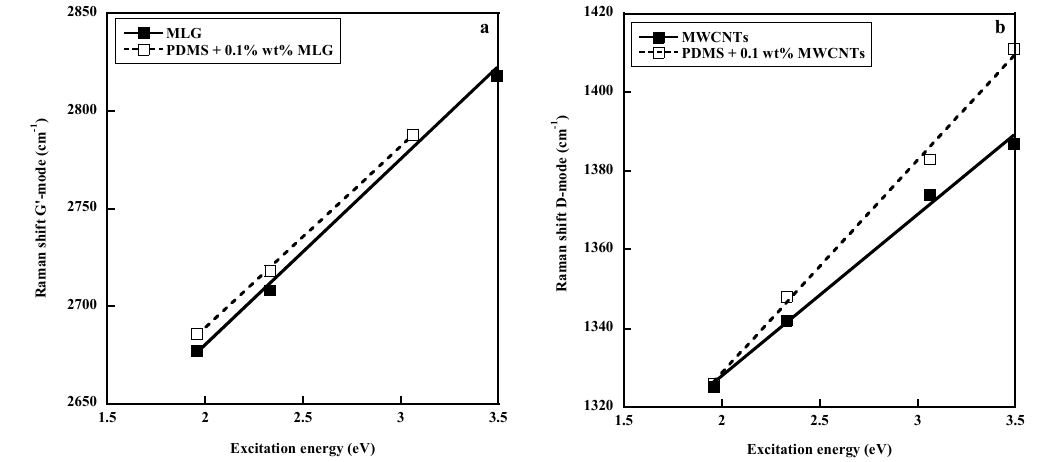
Figure 10. Comparison of the dispersive behavior of multilayer graphene MLG ( a ) and multiwall carbon nanotubes (MWCNTs) ( b ) in the pure state and embedded in a poly(dimethylsiloxane) (PDMS) matrix. Reprinted with permission from Elsevier. Reproduced by permission of Elsevier from L. Bokobza, J.-L. Bruneel, M. Couzi, Vibrational Spectroscopy, 2014, 74, 57–63.